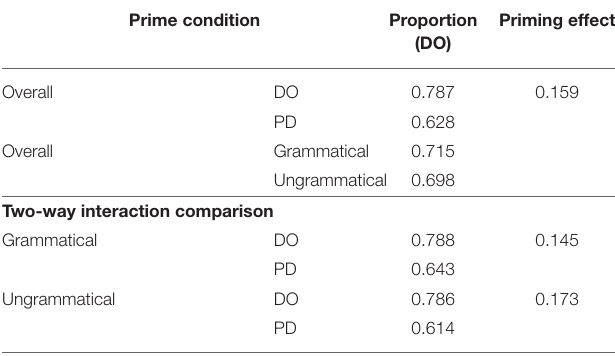
TABLE 4.2 | Experiment 2 proportion